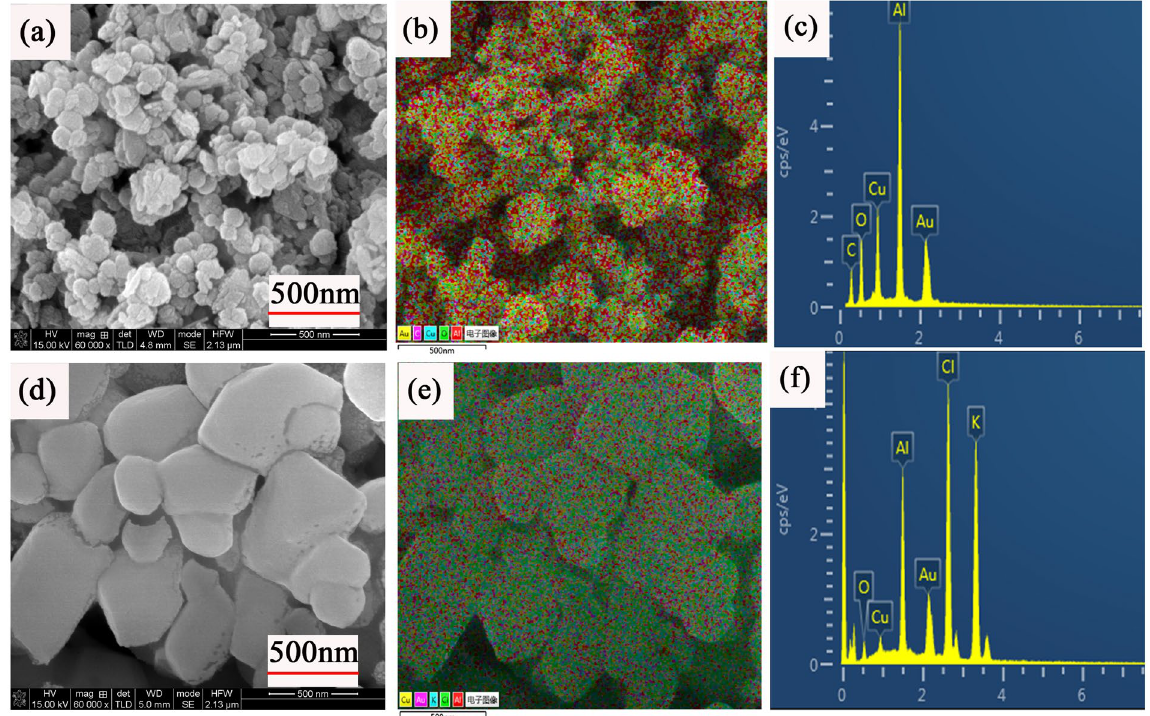
Figure 5. ( a ) SEM ( b ) Surface elements distribution ( c ) EDX images of ball-milling Al/CuO particles ( d ) SEM ( e ) Surface elements distribution ( f ) EDX images of Kp@Al/CuO nanocomposite particles.